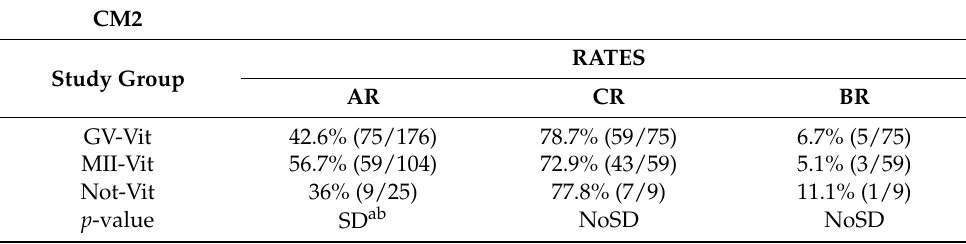
Table 4. Activation rate (AR), cleavage rate (CR), and blastocyst rate (BR) evaluated relative to the maturation stage prior to vitrification in the groups studied (GV-Vit, MII-Vit, and Not-Vit), both in CM2 (CCM supplemented medium). Average proportions by group and p -value. SD a (MII-Vit vs. Not-Vit, p -value= 0.037) and SD b (GV-Vit vs. MII-Vit, p -value=